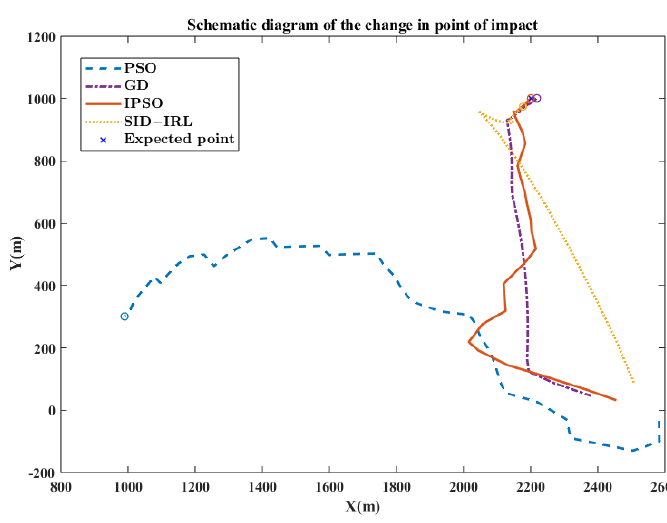
Figure 12. Change of impact point in case